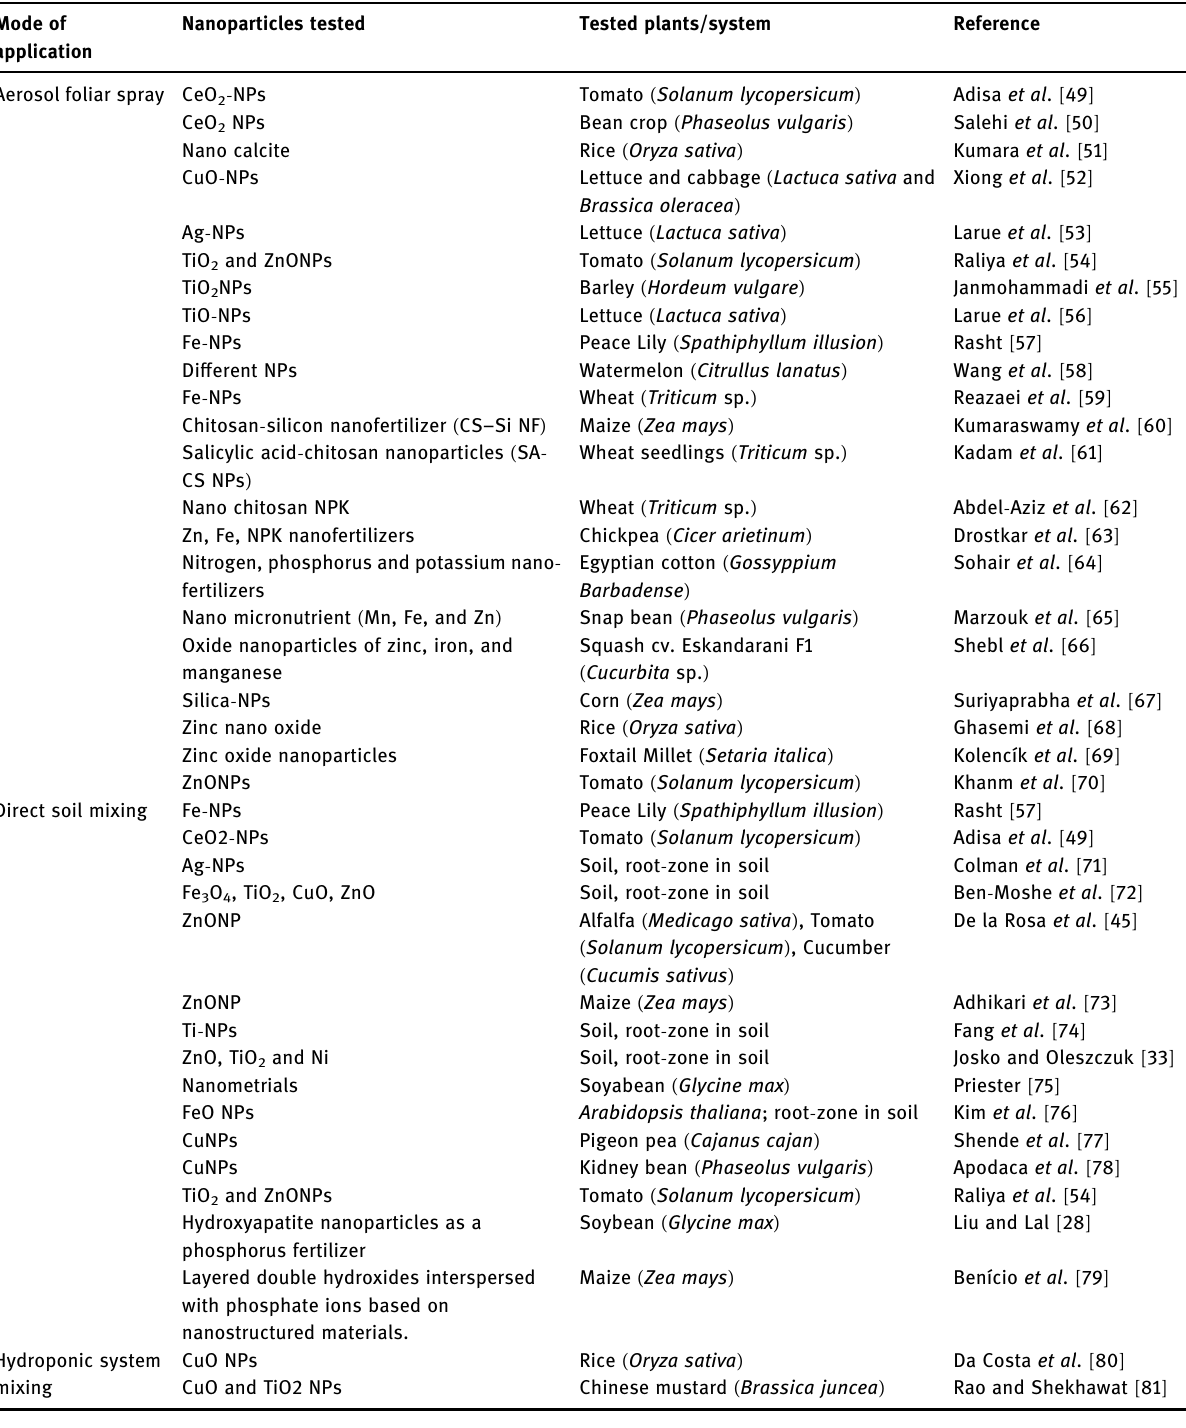
Table 3: Tested plants for the e ff ects of NPs through a particular mode of